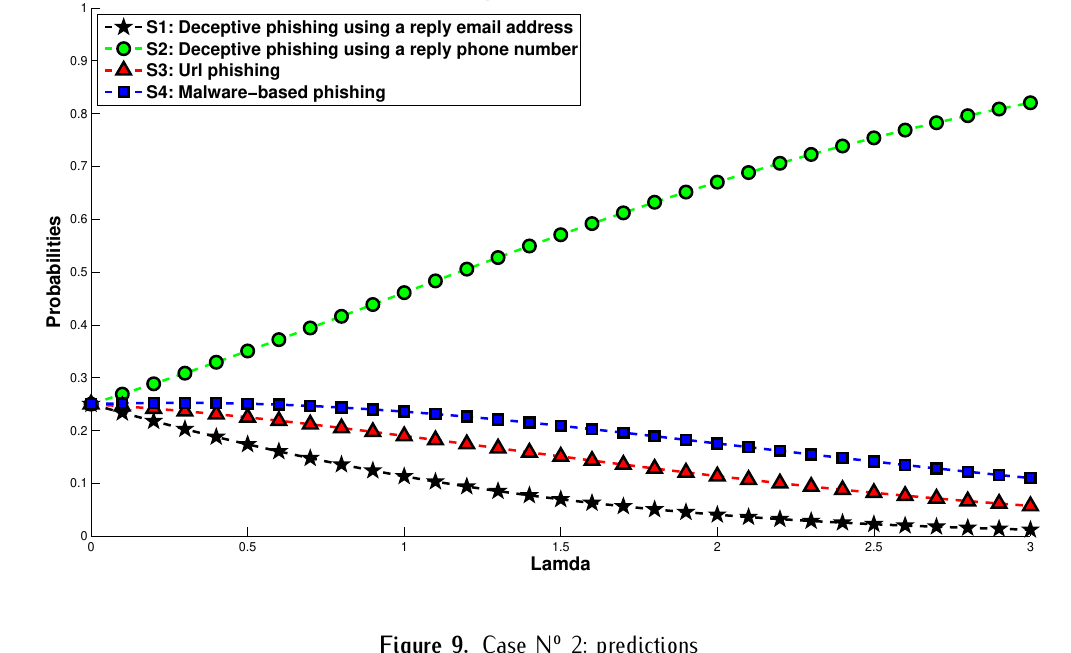
Figure 9. Case N o 2: